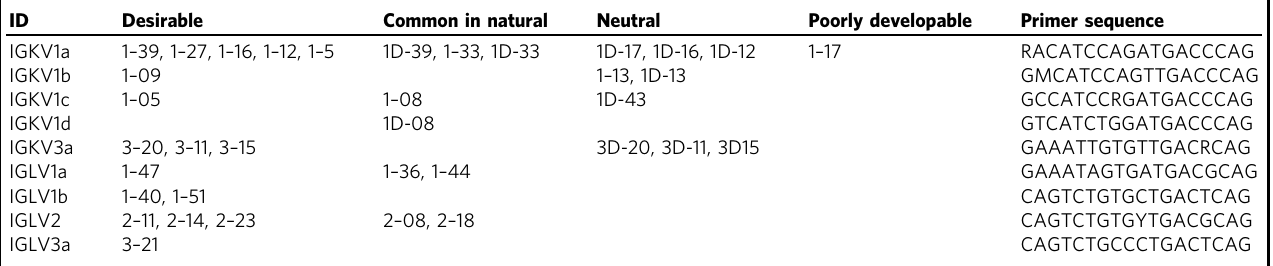
Table 2 IGKV and IGLV domain developability and primer